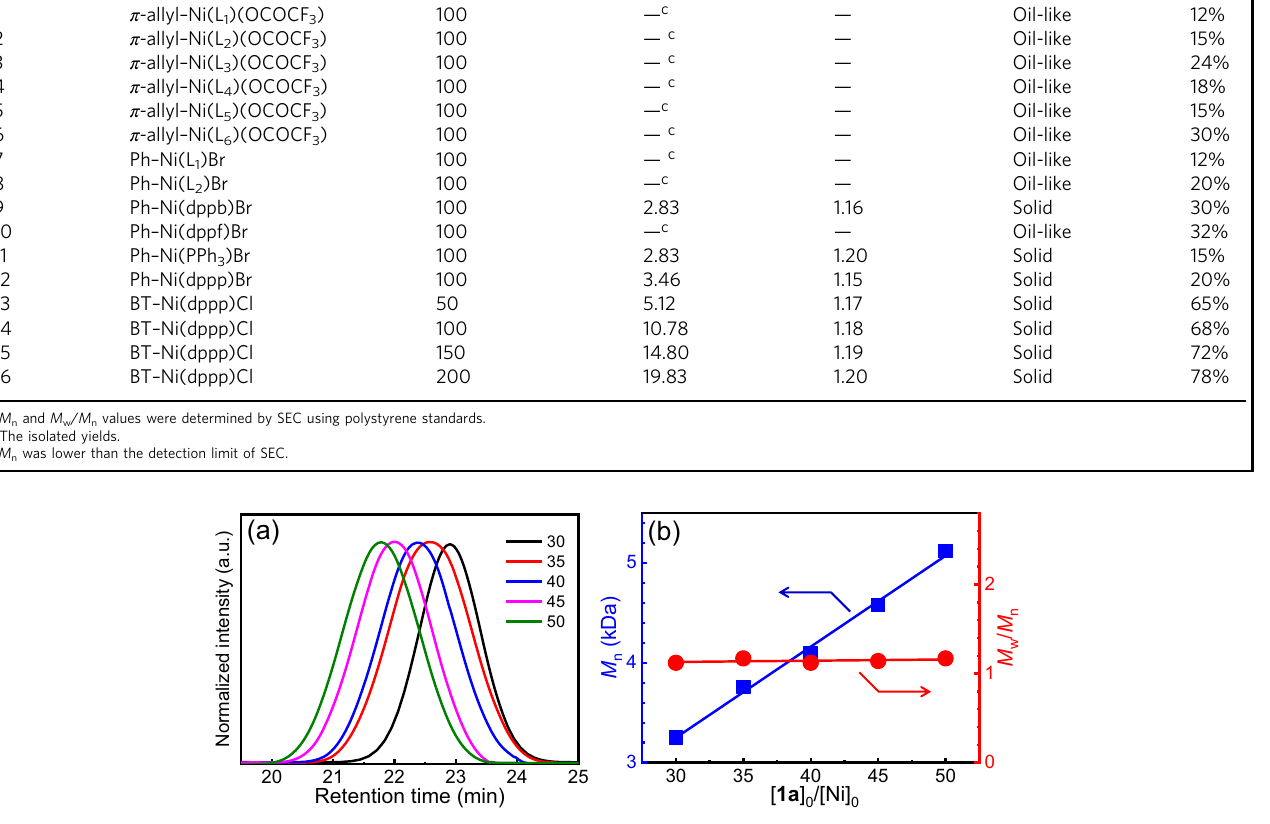
Table 1 Results for 1a polymerization using various Ni(II) catalysts. run